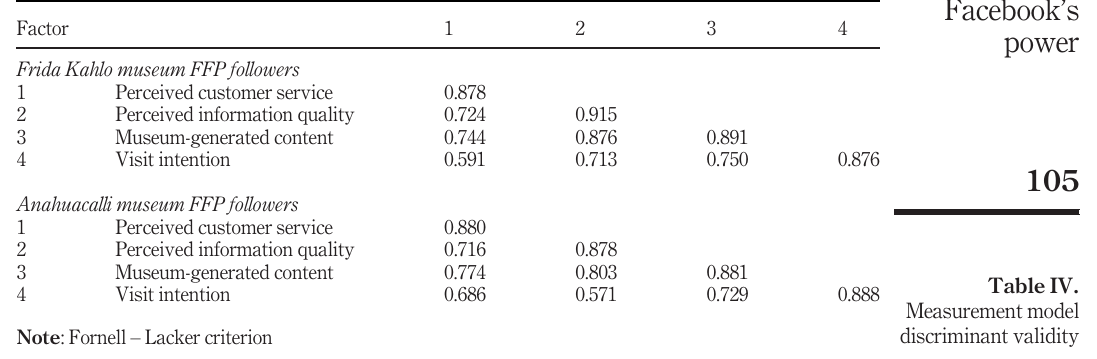
Table IV. Measurement model